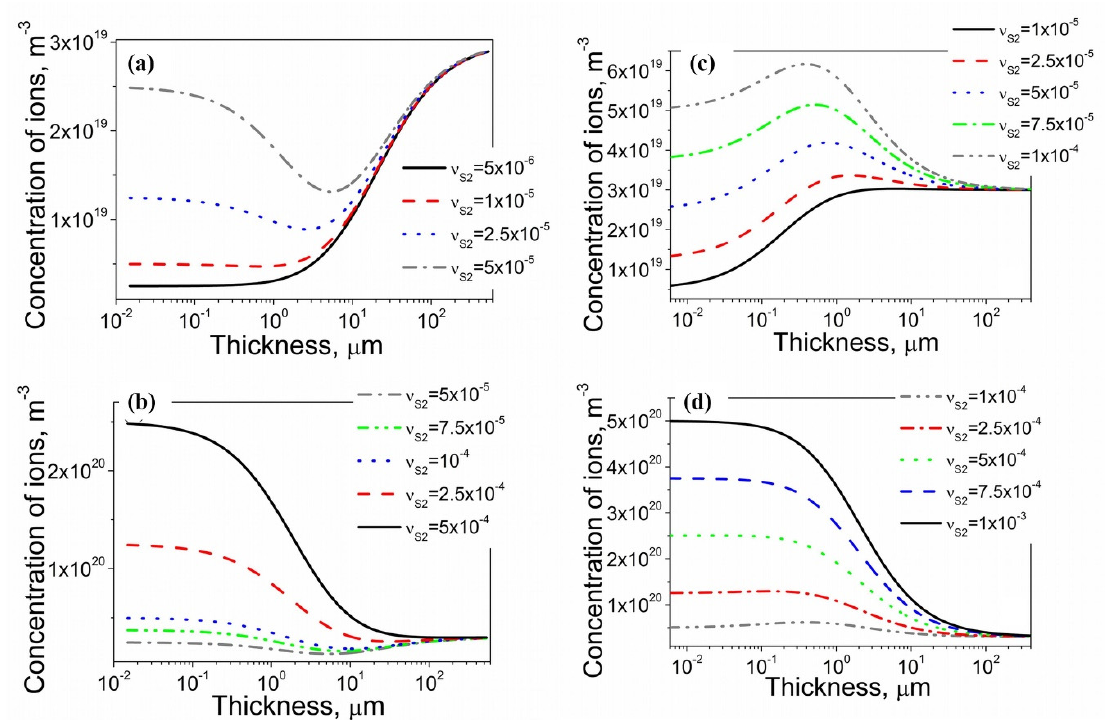
Figure 1. The total concentration of mobile ions, n , as a function of the cell gap calculated at several values of the contamination factor (cid:2021) (cid:3020)(cid:2870) . ( a ) Monotonous increase (solid and dashed curves) followed by a non-monotonous dependence with a minimum (dotted and dashed-dotted curves). ( b ) Monotonous decrease (solid and dashed curves) followed by a non-monotonous dependence with a minimum (dotted and dashed-dotted curves). ( c ) Monotonous increase (solid curve) followed by a non-monotonous dependence with a maximum (other curves). ( d ) Monotonous decrease (all curves except double-dotted-dashed curve). Additional information can be found in paper